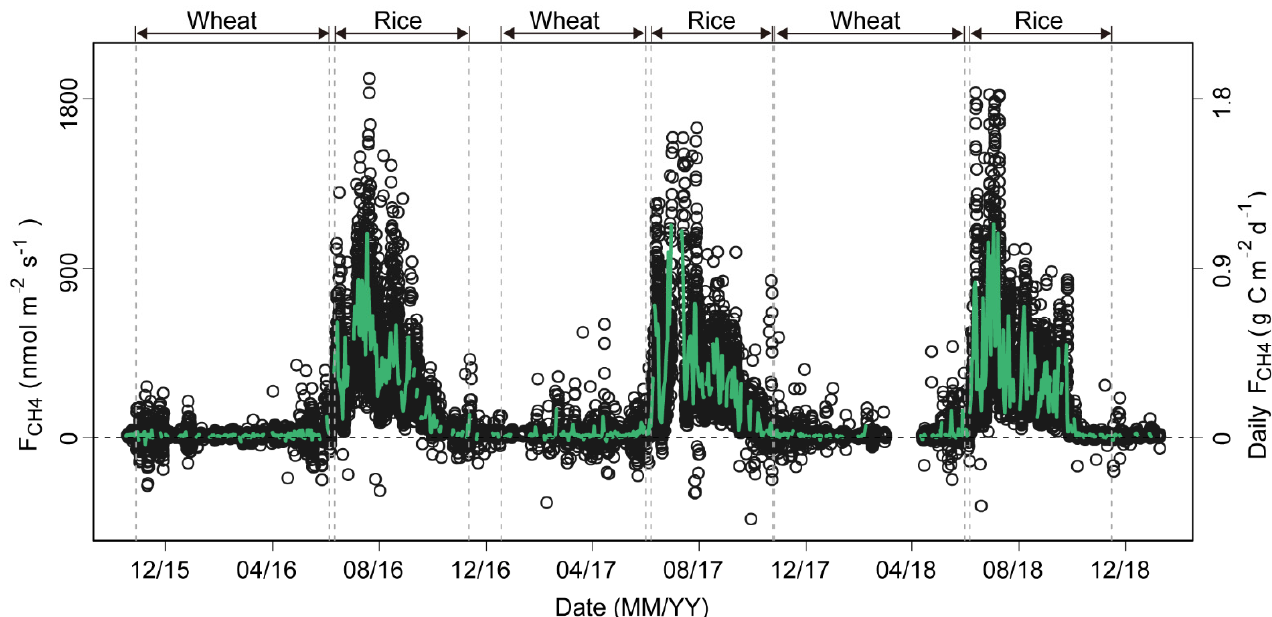
Figure 2. Time series of daily (green lines) and half-hourly (black circles) CH 4 fluxes during the rice growing season in 2016–2018.